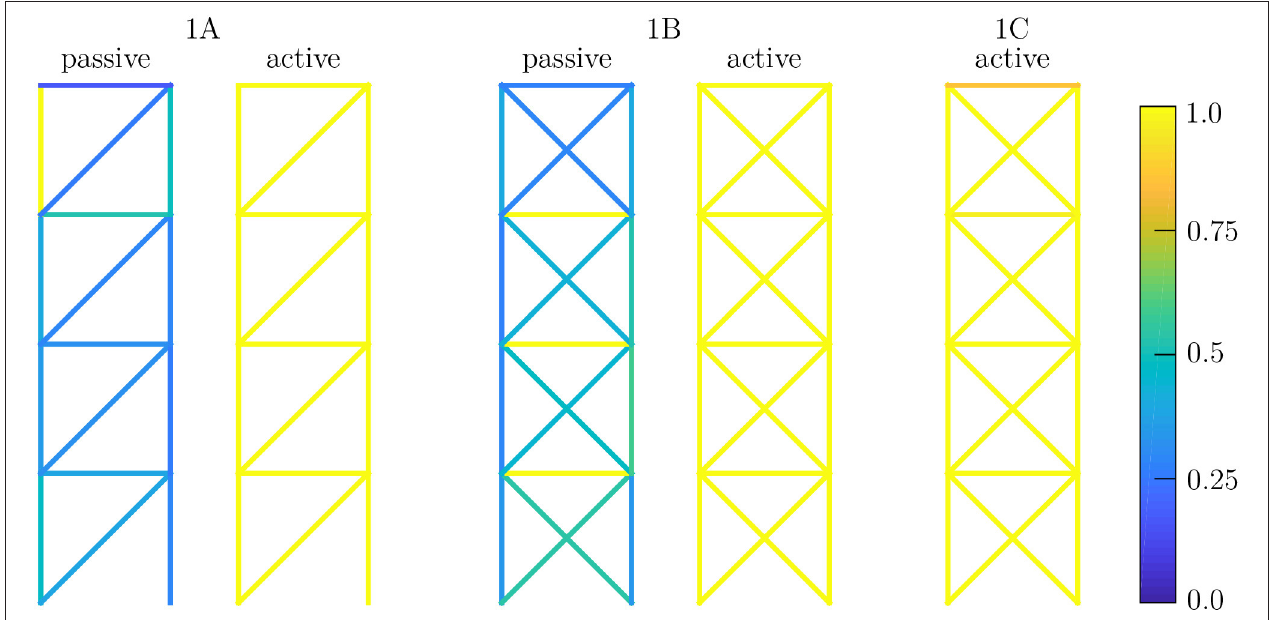
FIGURE 5 | Example 1, truss design: maximum utilization, envelope over all load